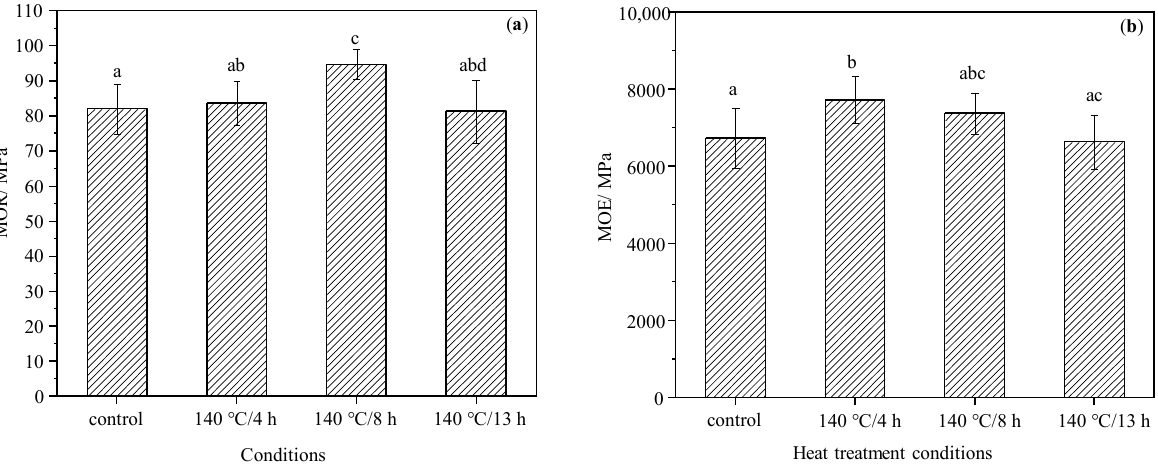
Figure 4. The MOR ( a ) and MOE ( b ) of the control and modified wood. Bars with different letters (left: a, ab, c and abd, and right: a, b, abc and ac) indicate significant differences ( p < 0.05) according to Duncan’s multiple range tests.